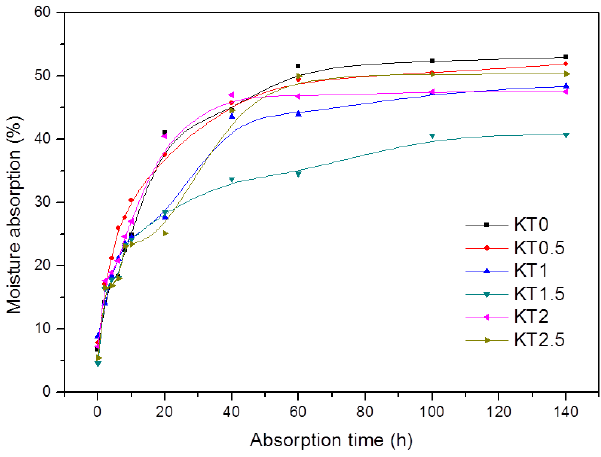
Figure 6. Moisture absorption of the composite films (KT0.5~KT2.5).